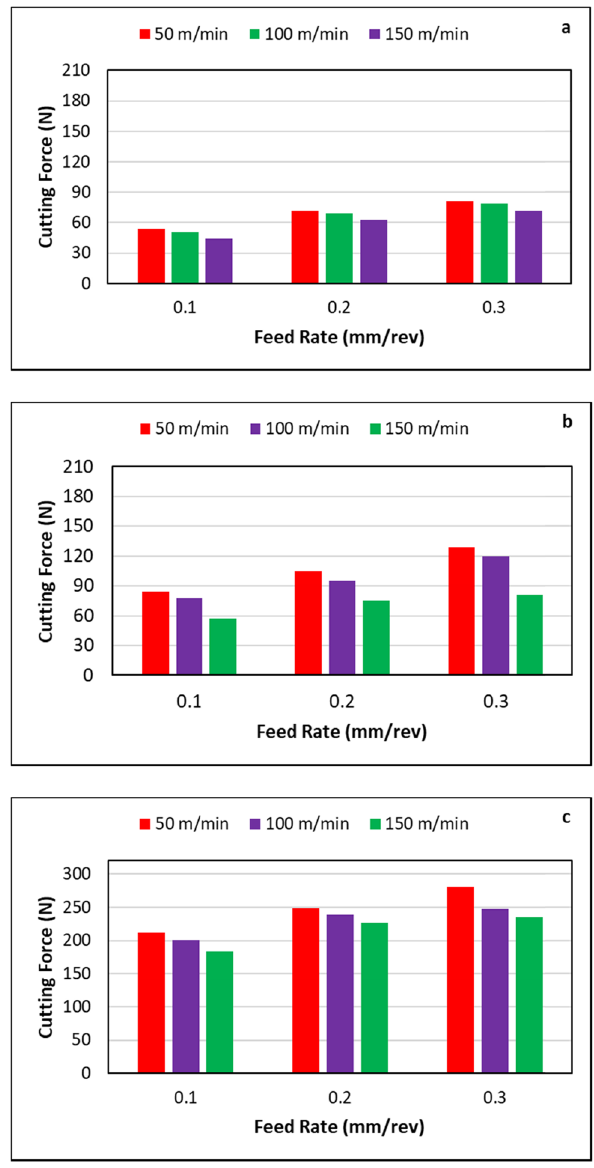
Figure 5: In fl uence of feed rate on cutting force at 30° fi ber orien - tation: ( a ) depth of cut 1 mm, ( b ) depth of cut 2 mm, and ( c ) depth of cut 3